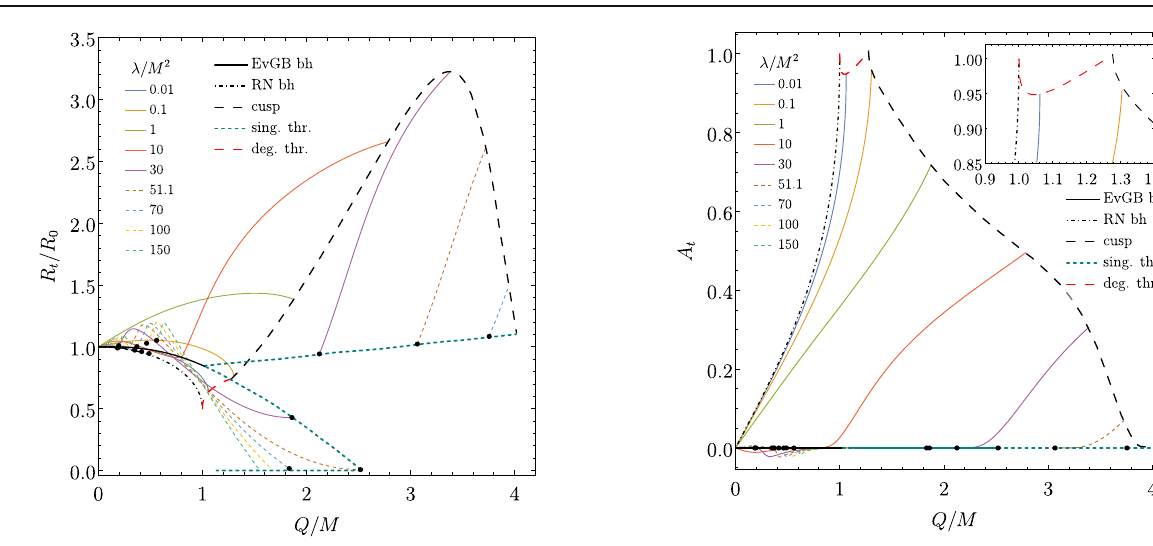
point of the boundary of wormholes with cusp